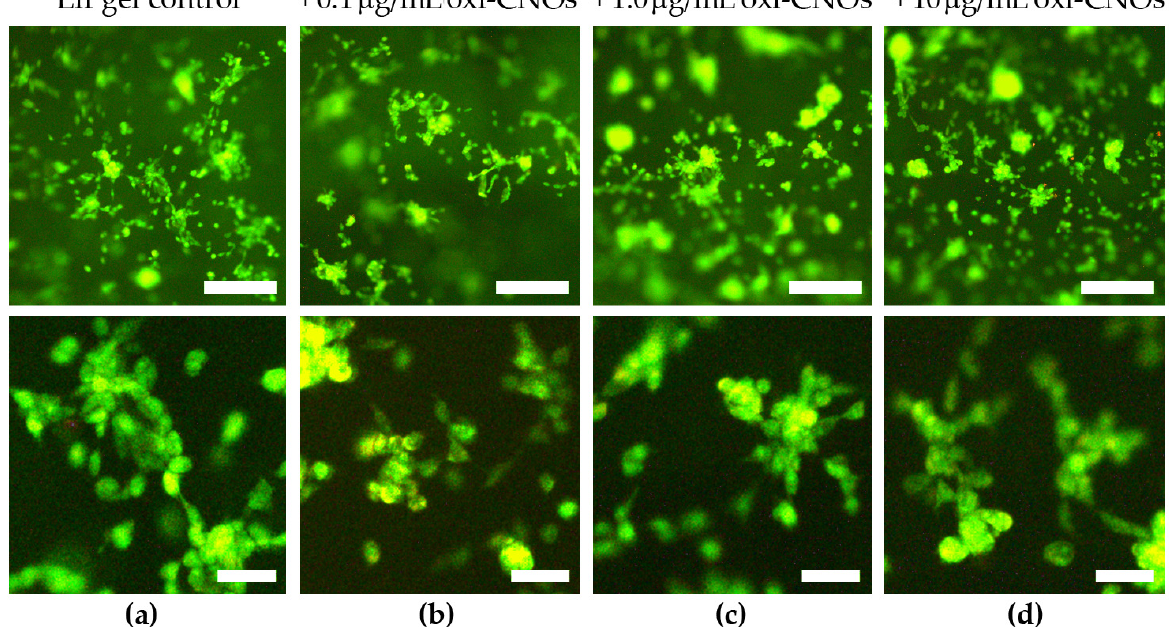
Figure 11. Live (green)/dead (red) fluorescence staining of fibroblasts grown in contact with the peptide hydrogel without ( a ) or with ( b – d ) oxi ‐ CNOs. Scalebars represent 50 μ m ( top panels ) or 10 μ m ( bottom panels ).